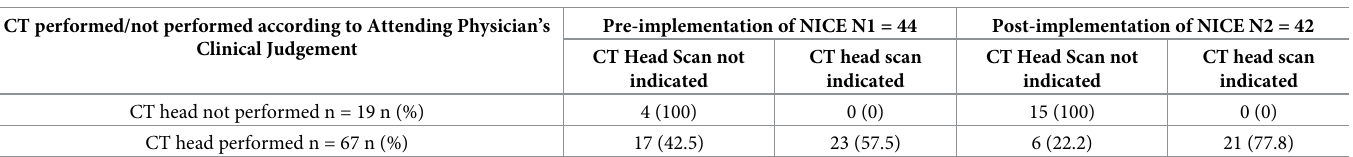
Table 5. Guideline adherence during different phases, n = 86. CT performed/not performed according to Attending Physician’s Clinical